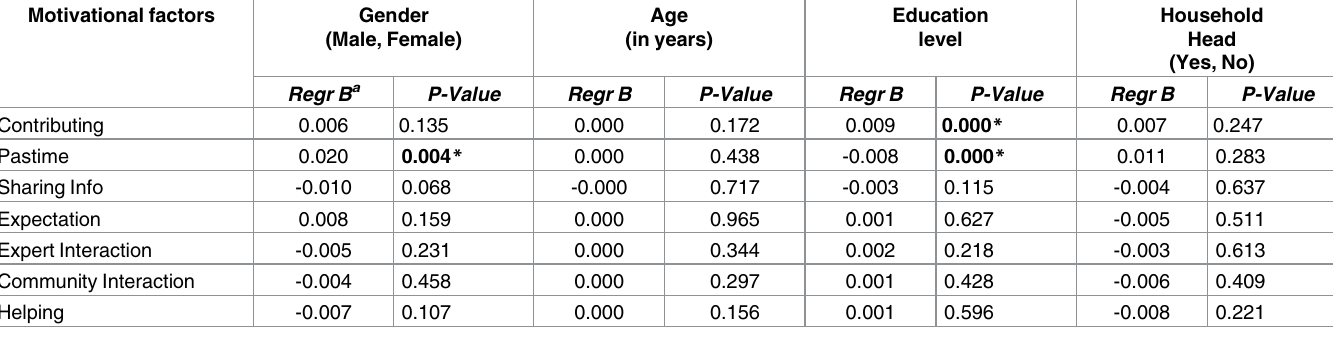
Table 5. Generalized linear model showing relationship between motivational factors and farmers’ characteristics using pooled data from the three countries. Motivational